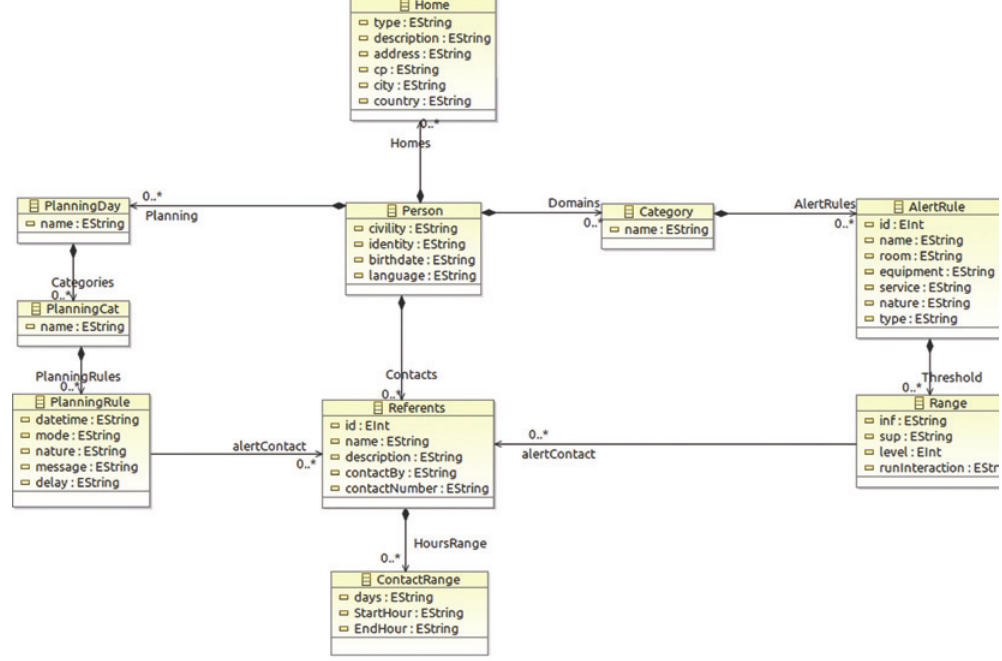
Figure 7: CNT Meta-model Handling Profile, Contacts, Planning, and